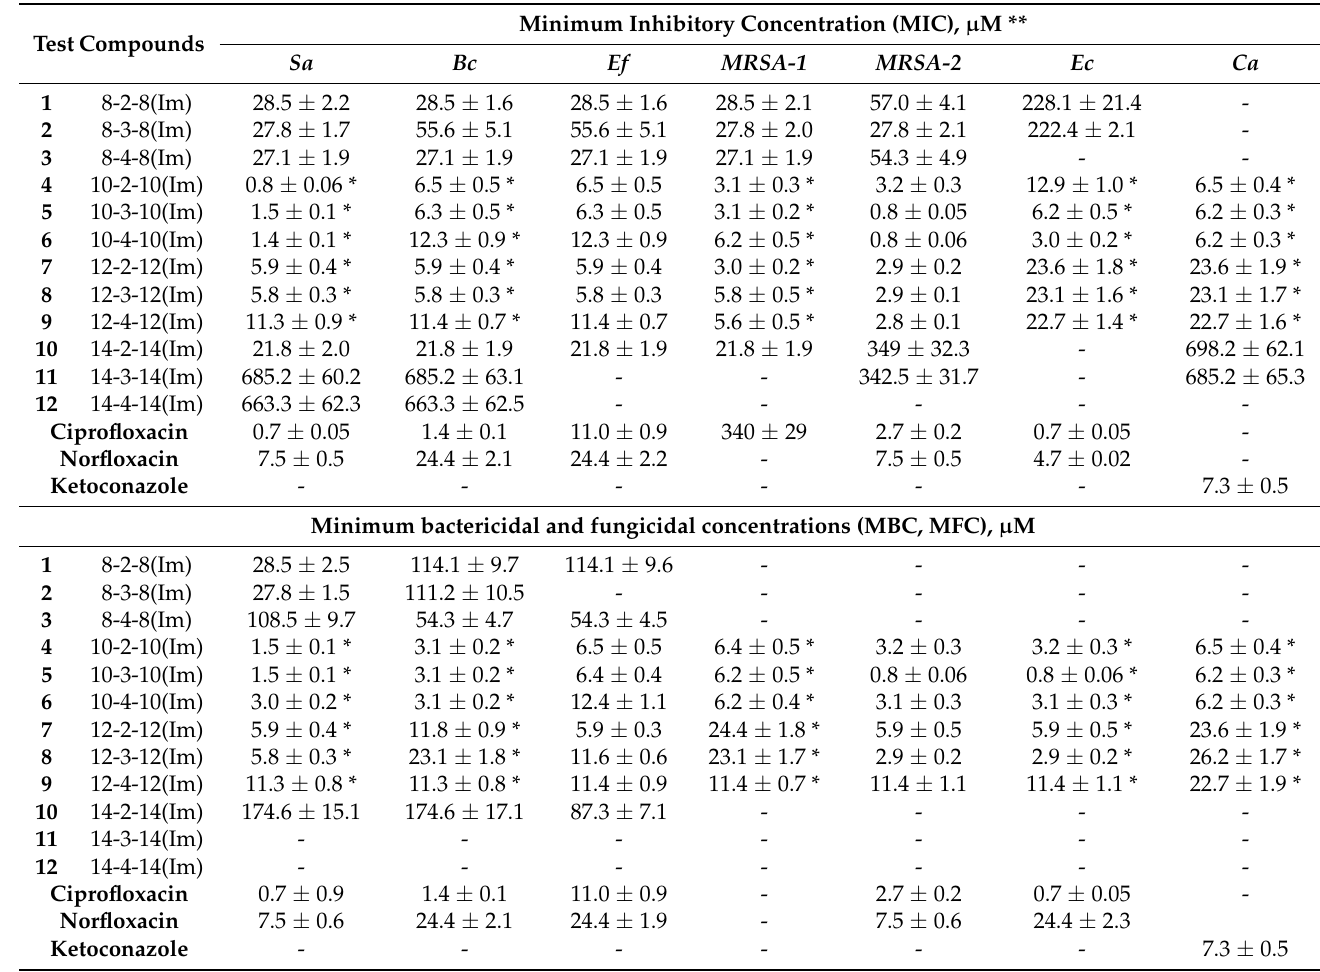
Table 1. Antimicrobial activity of dicationic imidazolium